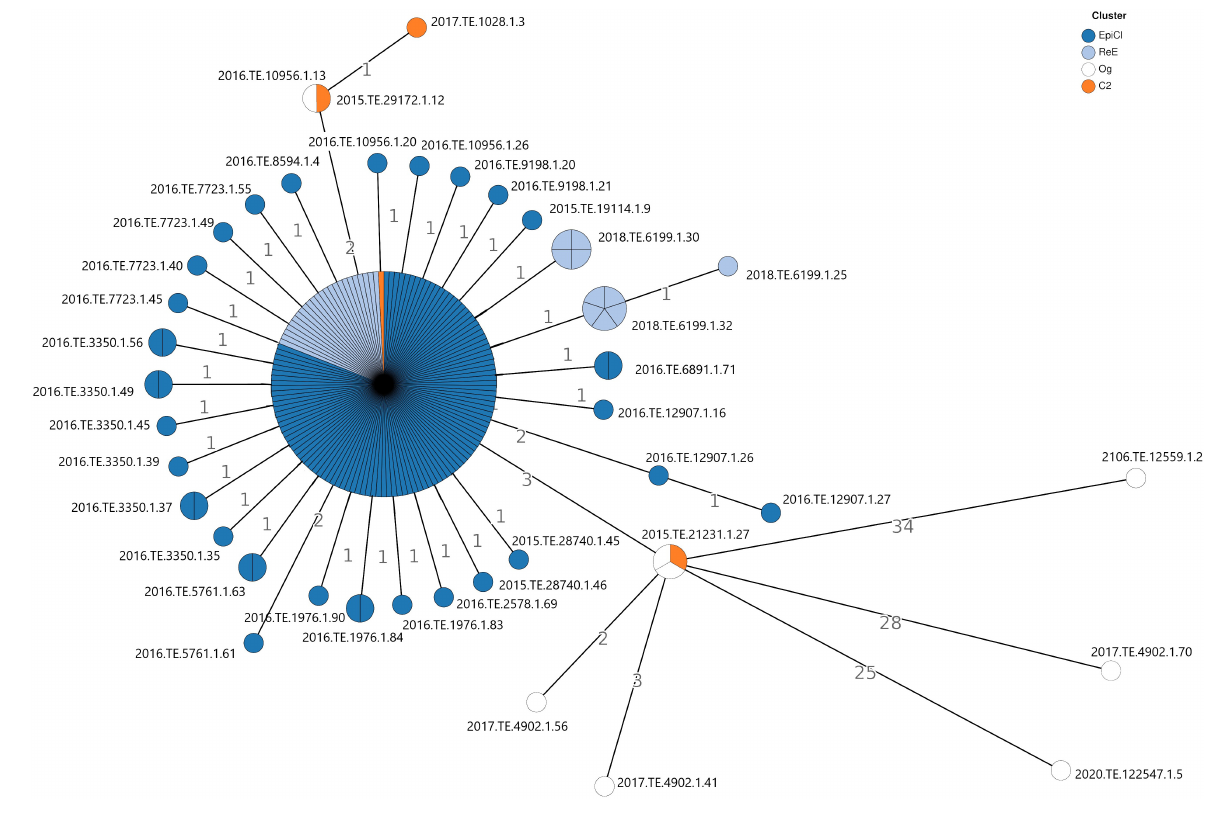
followed by the 10 isolates of the ReE not included in